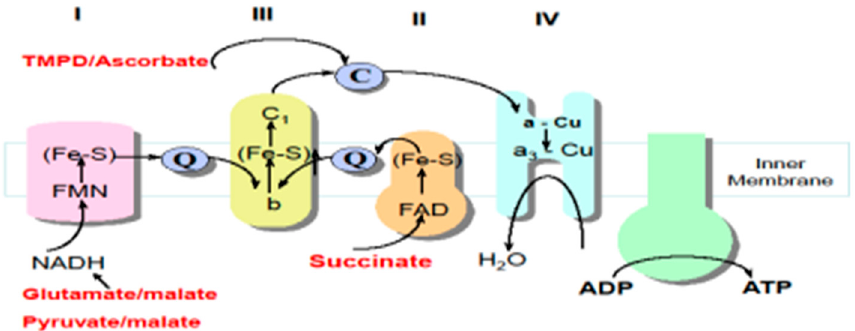
Figure 2. Substrates used in polarography to assess oxygen consumption rates illustrating their site of oxidation within the mitochondrial respiratory chain (MRC). C: cytochrome c, Q: CoQ10, TMPD: N,N,N ′ ,N ′ -Tetramethyl-p-phenylenediamine.